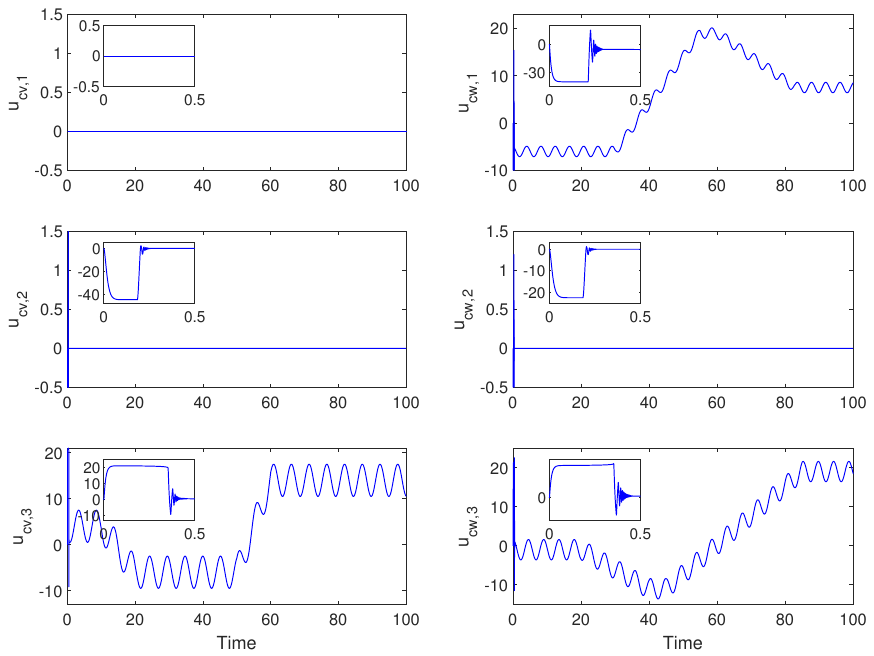
Figure 14. Compensation u d , i for i = 1,2,3 from the